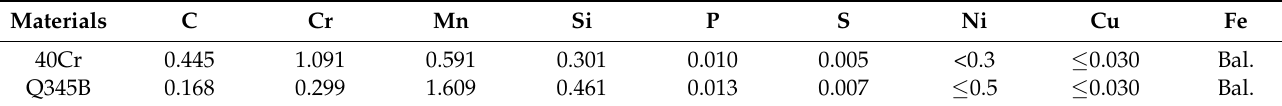
Table 2. Chemical compositions of 40Cr and Q345B (wt.%).